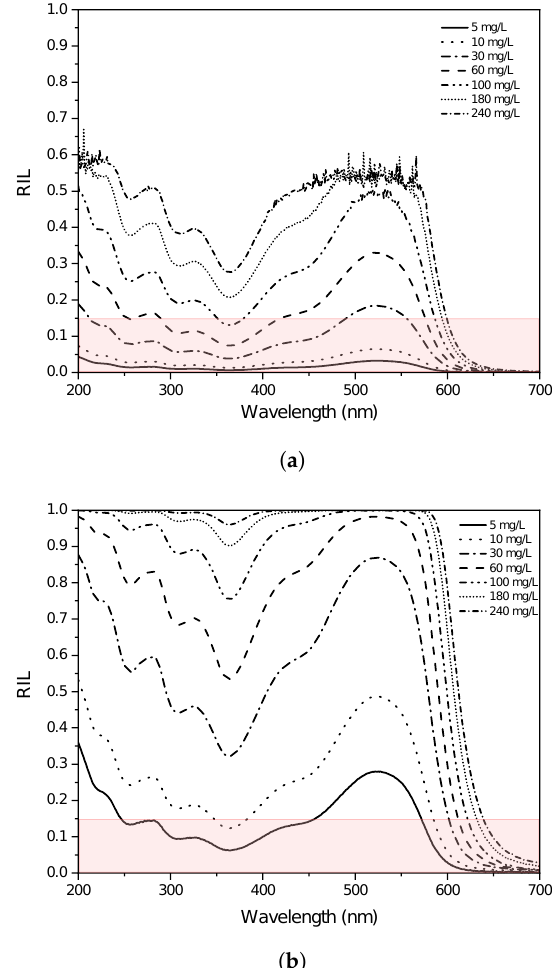
Figure 7. RIL spectra with different RR239 concentration for δ equal to 0.1 cm ( a ) and 1 cm ( b